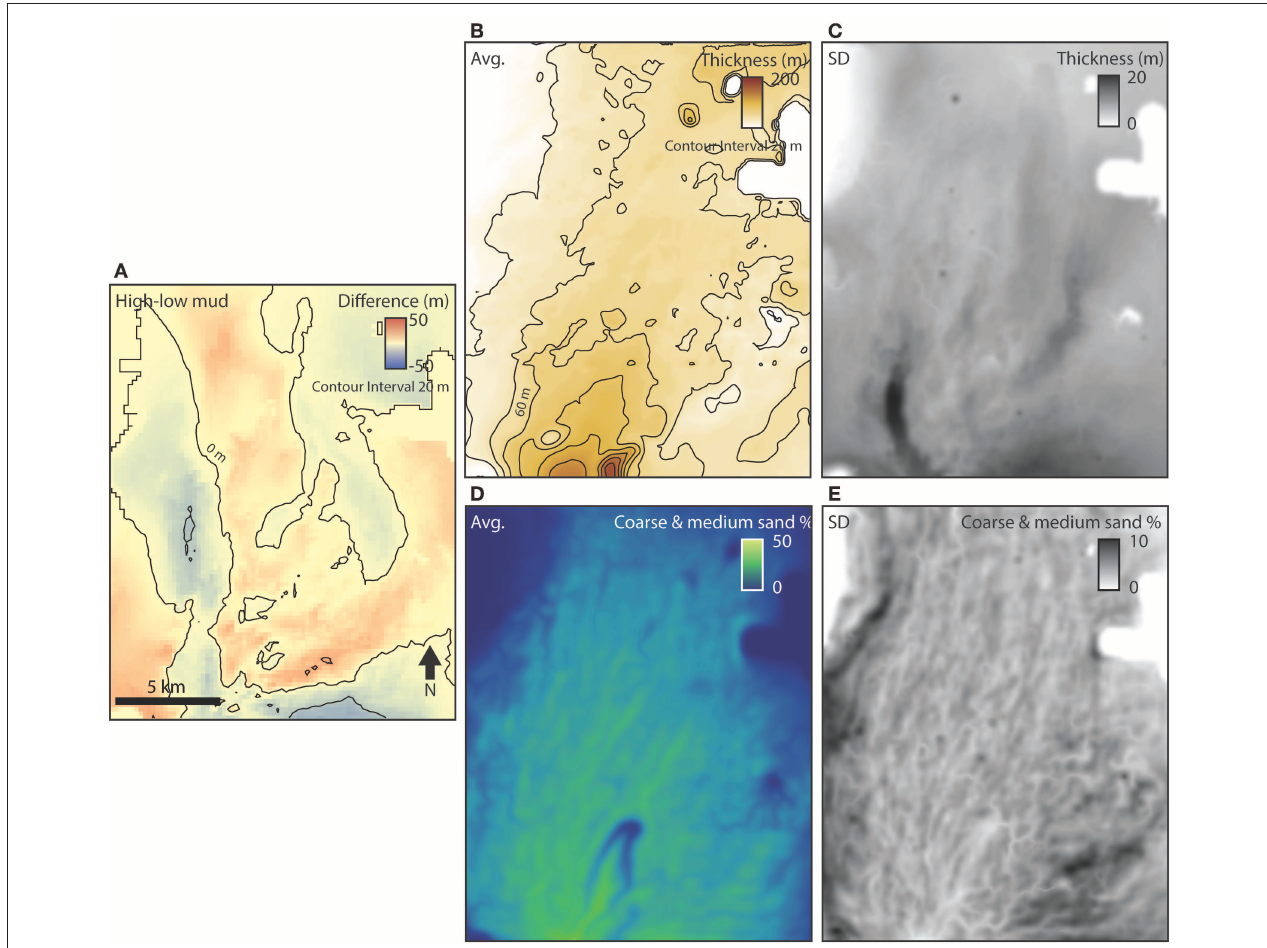
FIGURE 7 | (A) Difference in thickness between the high and low mud load models. (B–E) Simulation results. (B) Average of thicknesses. (C) Standard deviation of thicknesses. (D) Average of coarse and medium sand percentages. (E) Standard deviation of coarse and medium sand